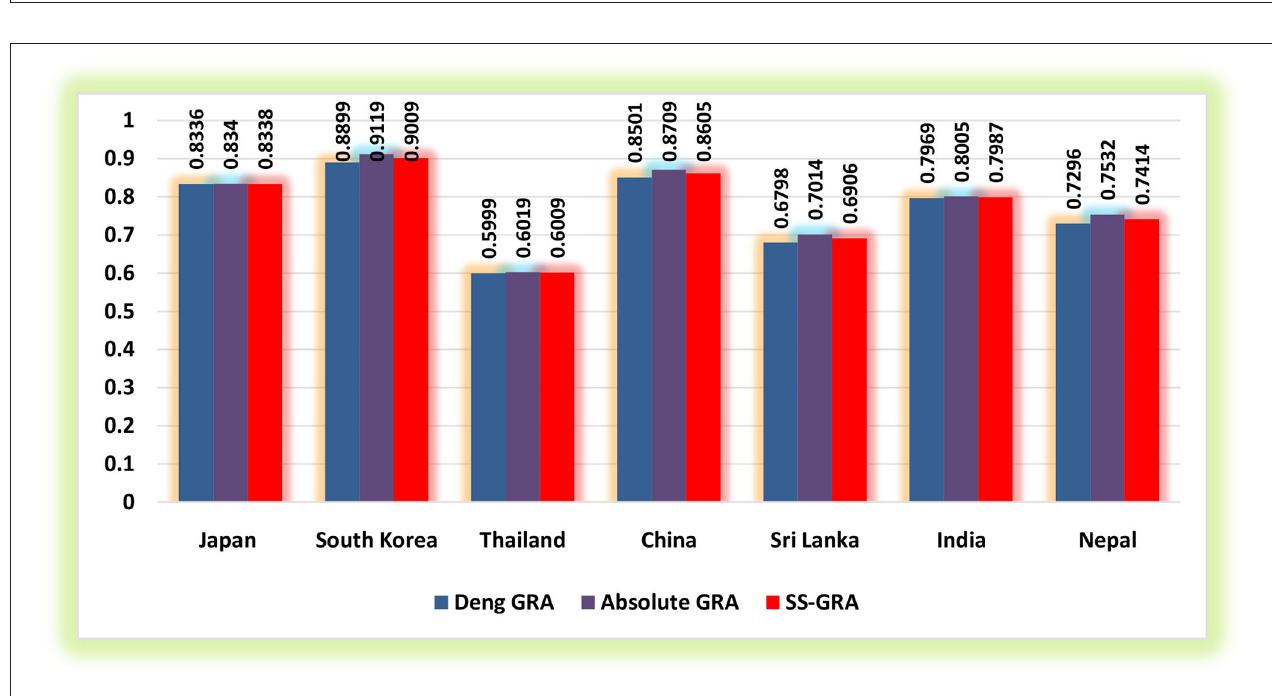
FIGURE 2 | Grey relational assessment of IHD mortality and exposure to ambient PM 2.5